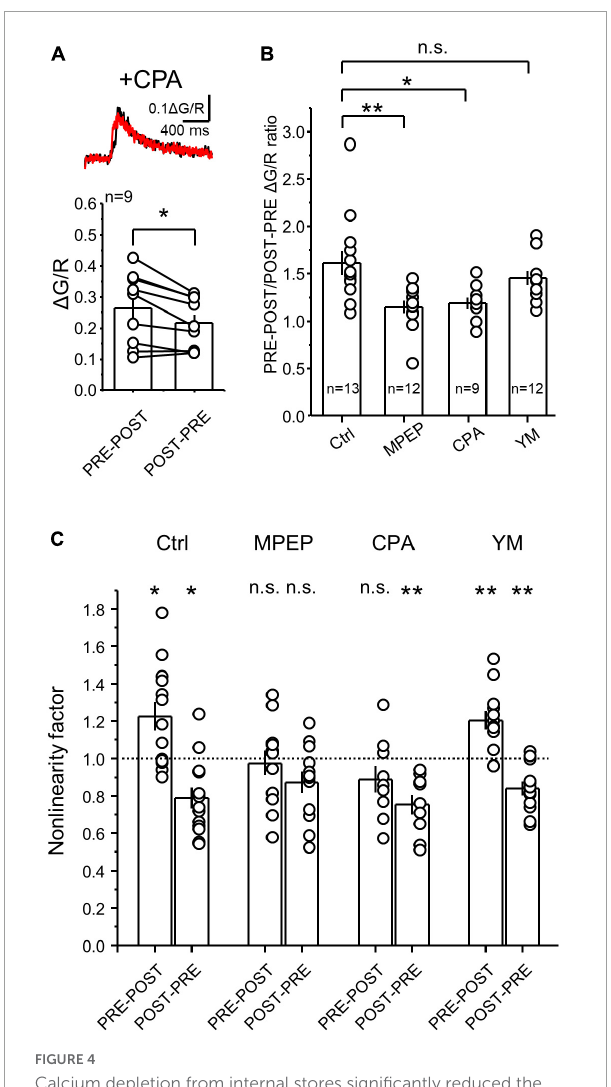
FIGURE4 Calcium depletion from internal stores significantly reduced the difference between PRE-POST and POST-PRE CaTs at MF-CA3 synapses. (A) Representative CaTs induced by PRE-POST and POST-PRE stimulation in the presence of the SERCA pump blocker cyclopiazonic acid (CPA) (top). Brain slices were incubated for 30 min in 30 µ M CPA which was also continuously perfused. Summary plot showing the effect of CPA on peak (cid:49) G/R measured during PRE-POST and POST-PRE stimulation (bottom). (B) PRE-POST and POST-PRE CaT ratio under different experimental conditions: Ctrl (no drugs), 4 µ M MPEP, 30 µ M CPA and 1 µ M YM. One Way ANOVA; F = 5.86458; p = 0.00194; DF = 3; Ctrl vs